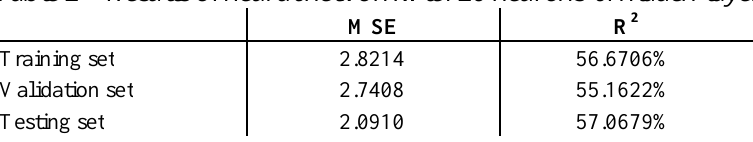
Table 1 – Results of neural network with 10 neurons in hidden layer